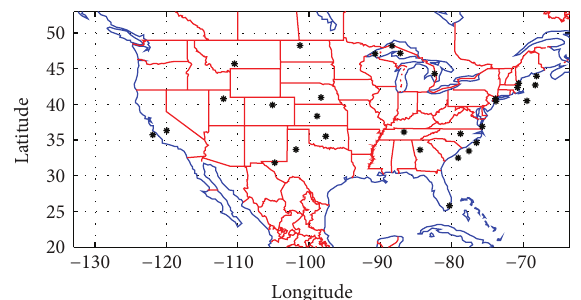
Figure 3: Locations of selected stations across the CONUS region used in this study for